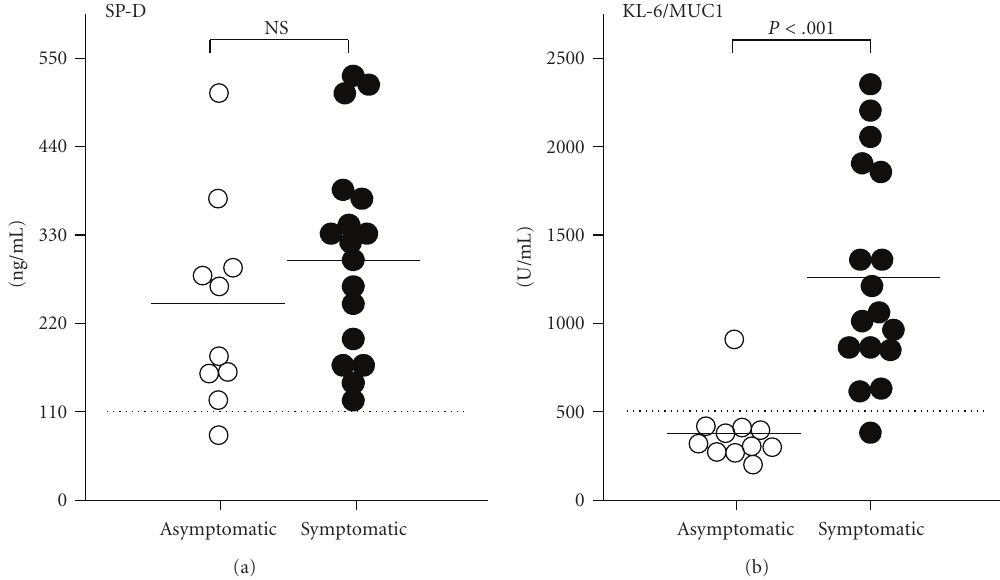
Figure 1: Comparison of serum levels of SP-D and KL-6/MUC1 between asymptomatic patients with honeycombing and symptomatic IPF patients. Both groups have elevated SP-D without statistic di ff erence, but KL-6/MUC1 was significantly higher in symptomatic IPF patients. Dotted lines represent mean values of SP-D (110ng/ml) and KL-6/MUC-1 (500 U/ml).